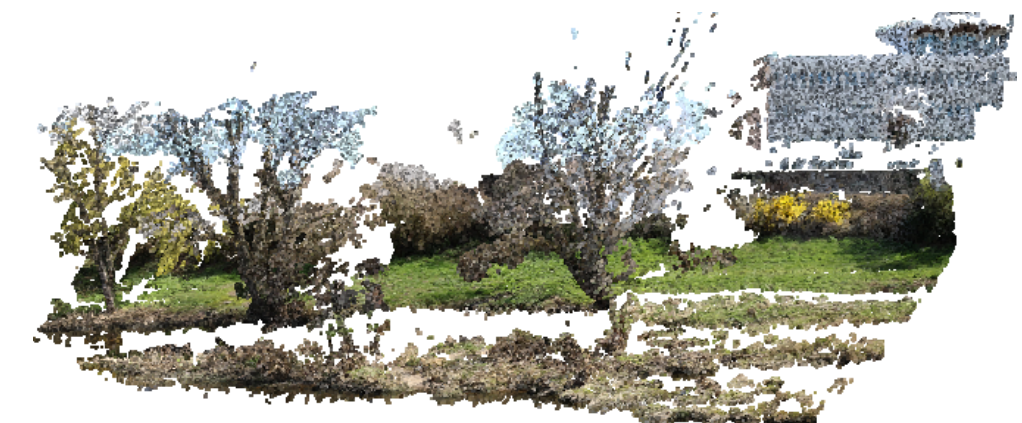
Figure 3. Overview of the 3D reconstruction from the 3200 × 2400